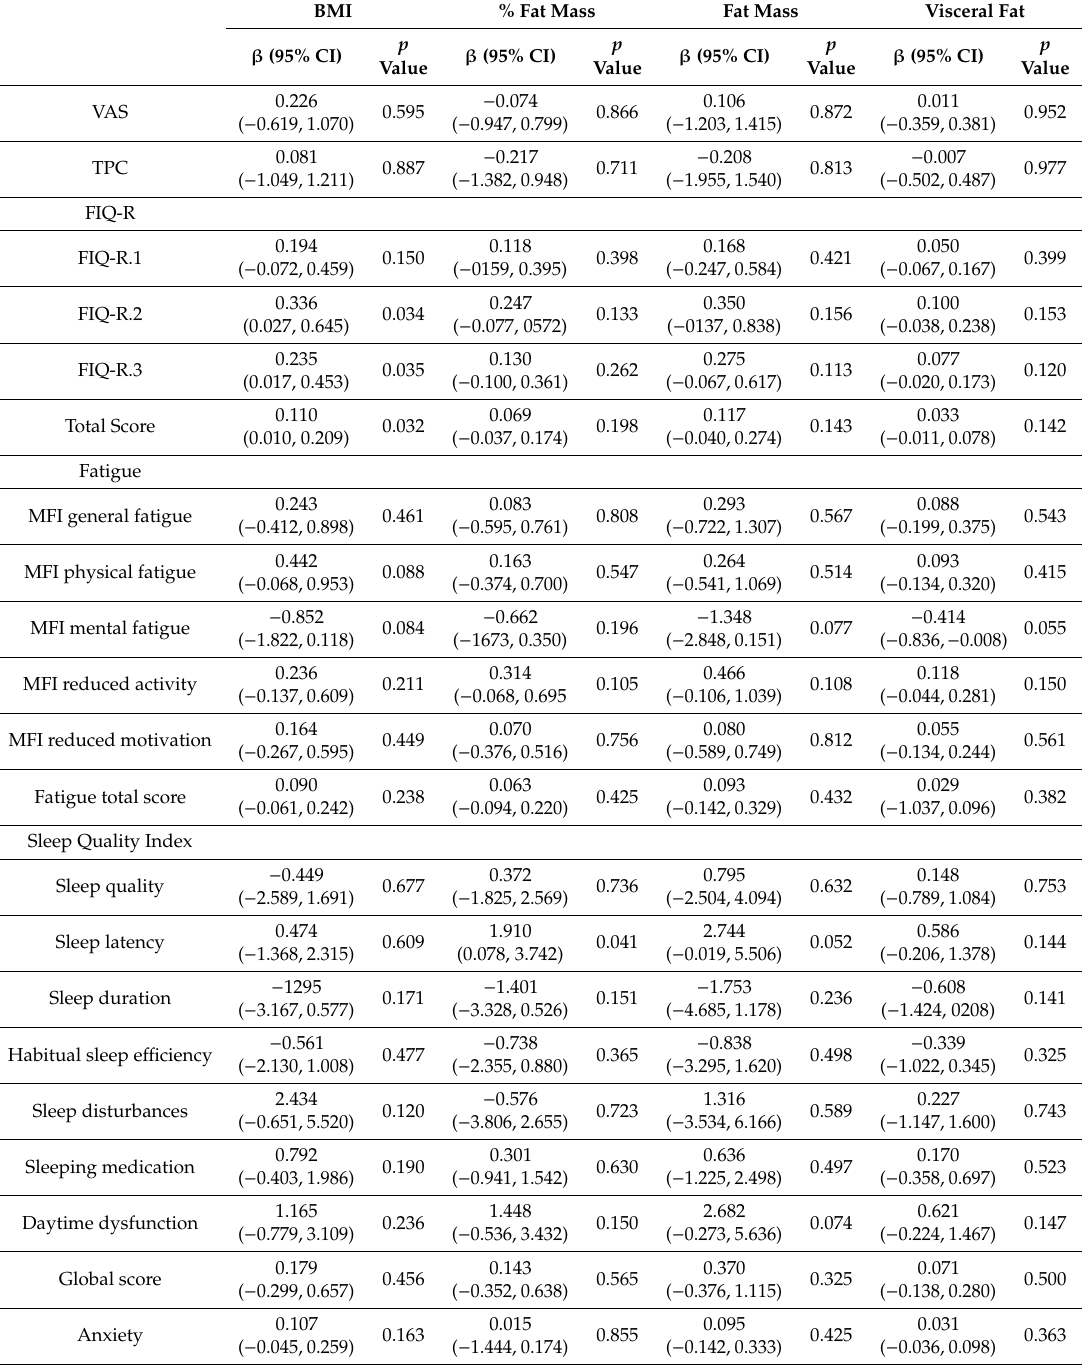
Table 3. Associations among body composition, VAS, TPC, FIQ-R, fatigue, sleep, and anxiety in women with